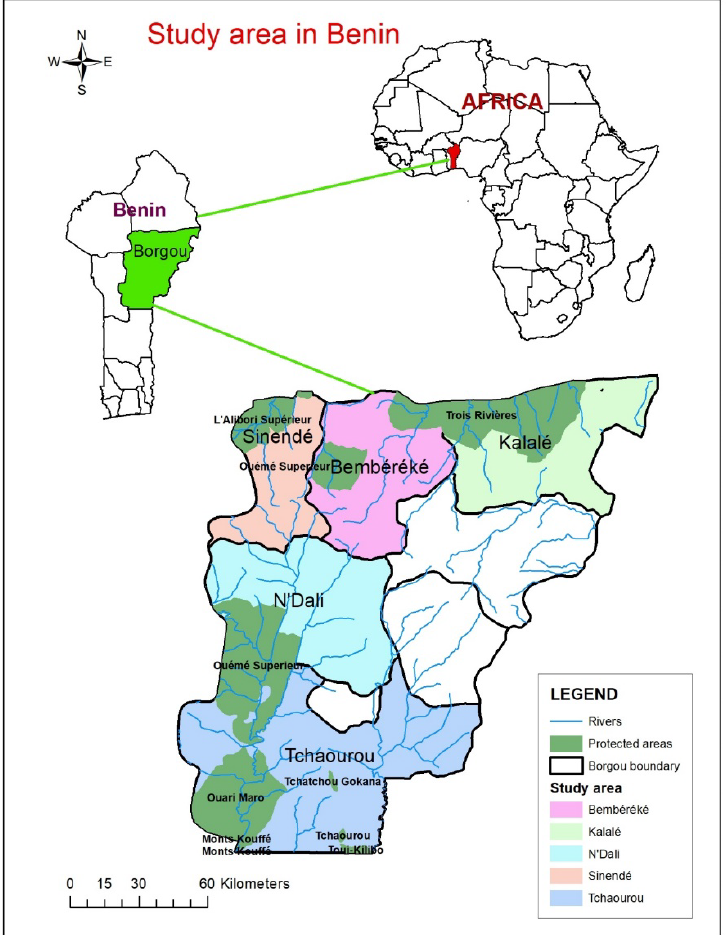
Figure 1. Study area.